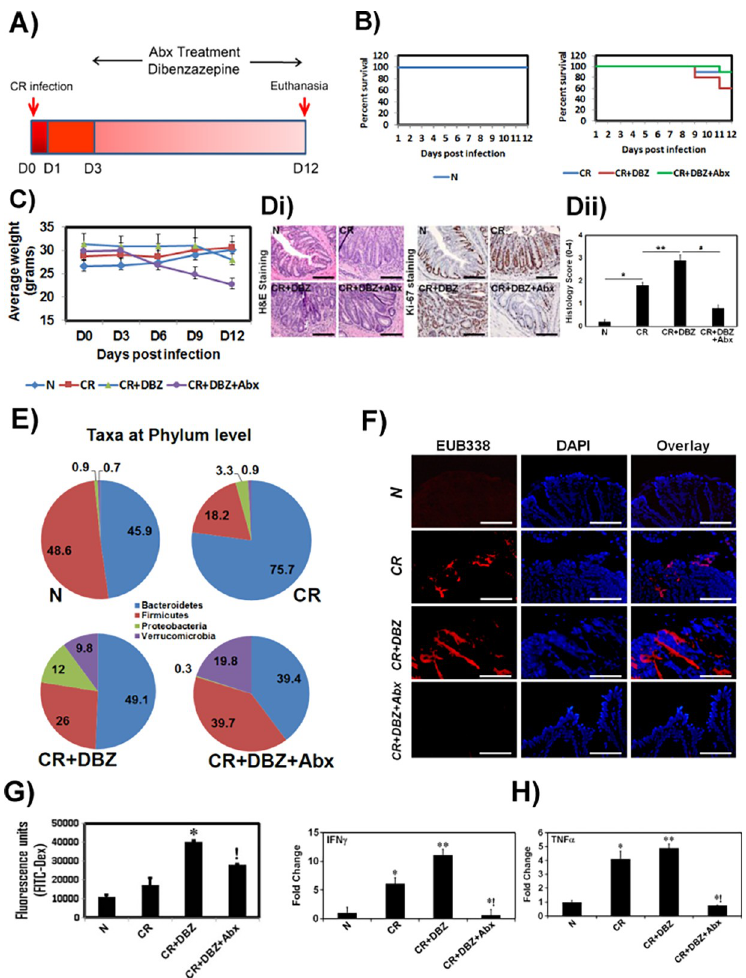
Fig 5. Effect of antibiotics treatment on amelioration of colitis. A. Schema of CR infection and DBZ and antibiotics treatment (1g/l metronidazole and 0.2 g/l ciprofloxacin). B. Survival kinetics for mice in indicated groups (n = 5 independent experiments). C. Periodic weight measurement of mice in various treatment groups (Error bars represent the SD of samples within the group; p < 0.05; n = 5 per group). D. Representative hematoxylin and eosin (H&E; left panel) and Ki-67 (right panel) staining of colon sections prepared from the indicated groups (bar = 100 μ m; n = 5 independent experiments). E. The microbial composition at the phyla level in the feces of N, CR, CR+DBZ and CR +DBZ+Abx-treated mice (#s in the chart represent % of each phyla) (n = 10 mice/group). F. The bacteria in the colonic tissues of N, CR, CR+DBZ, and CR+DBZ+Abx-treated mice were detected by FISH using a general bacterial 16S probe (red, TexasRed-Eub338; Bar = 100 μ m; n = 3 independent experiments). DAPI was used as counter-stain. G. Mice in indicated groups were subjected to gavage with FITC-D, and serum concentrations, shown as fluorescence units, were measured 4h later. � , p < 0.05 versus CR; !, p < 0.05 versus CR+DBZ; n = 3 independent experiments. H. qPCR to examine expression levels of pro-inflammatory cytokines, IFN γ and TNF α in the indicated groups ( � , �� p < 0.05; n = 3 independent